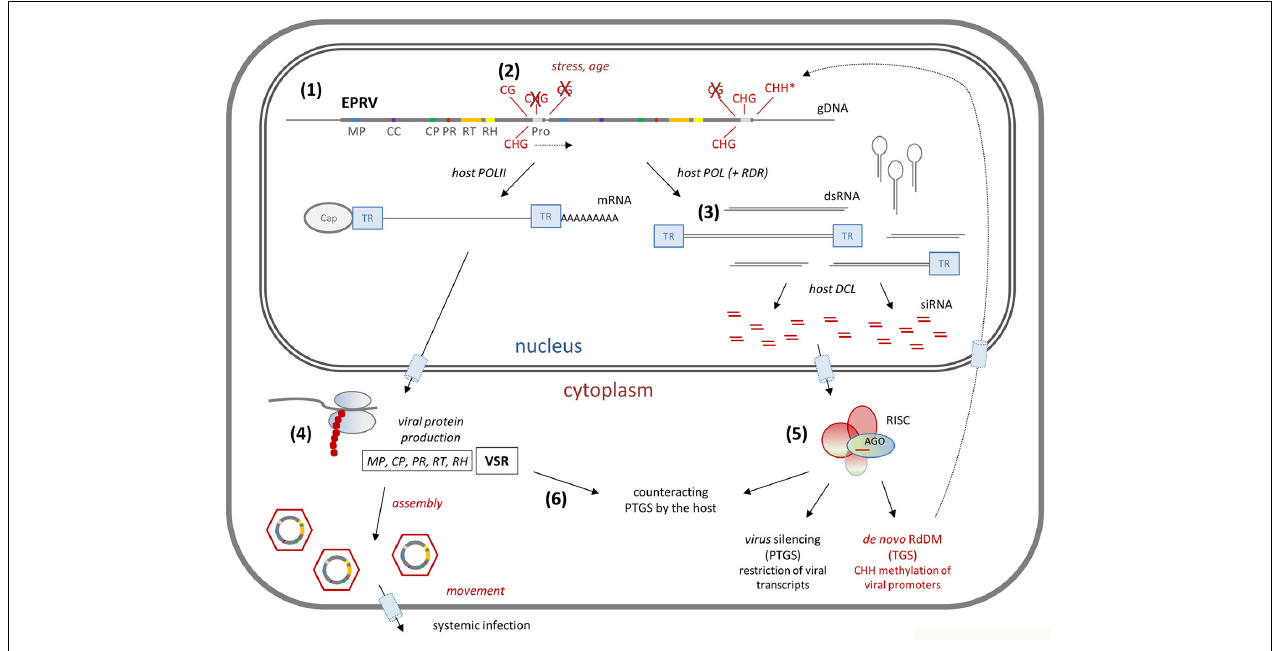
FIGURE 2 | RNA interference model for inducible endogenous pararetroviruses (EPRV). (1) EPRVs in the plant genome (see Figure 1B ) are usually off-frame and degraded, severely hampering full-length transcription. Sometimes, complete PRVs are integrated in tandem, as is shown here and was found for petunia vein clearing virus (PVCV) in P. hybrida (Richert-Pöggeler et al., 2003), through which full-length transcription can be rescued (POL = Polymerase). (2) Normally, EPRV promoters (Pro) are methylated, leading to transcriptional gene silencing (TGS); in promoters of endogenous PVCV (ePVCV) high levels of CG and CHG methylation were found (Kuriyama et al., 2020). Under the influence of stress or aging silencing can be reduced; ePVCV became transcribed and activated in older P. hybrida . (3) Active promoters may also lead to a diversity of incomplete viral transcripts, which serve as templates for dsRNA production, particularly via the formation of reverse complemental transcripts from reverse oriented EPRVs, secondary structures within the terminal repeats (TR), and action of host RNA dependent RNA polymerase (RDR). The dsRNAs trigger the host RNA silencing machinery, Dicer-like ( DCL) proteins excise them into 21, 22, and 24 nt small interfering (si)RNAs. (4) Viral proteins are produced by the host ribosomal machinery, among them movement protein (MP), capsid protein (CP), protease (PR), reverse transcriptase (RT), RNase H (RH), and viral suppressors of RNA silencing (VSRs). (5) The siRNAs load onto Argonaut (AGO) proteins in RNA induced silencing complexes (RISC) to guide them to their targets: 21 nt siRNAs, produced by DCL 4 (or DCL 1), often load onto AGO1 to function in post-transcriptional gene silencing (PTGS) via transcript cutting; 24 nt siRNAs, produced by DCL 3, mainly load on AGO4 to function in TGS via RNA dependent DNA methylation (RdDM) after transporting back to the nucleus. Activation of PVCV in P. hybrida resulted in increased levels of small RNAs and de novo CHH methylation (*) in the promoters of EPRVs (Kuriyama et al., 2020). (6) VSR interferes with the host silencing machinery to decrease virus degradation, ending up in an arms race between host induced silencing of the virus and viral induced silencing of the